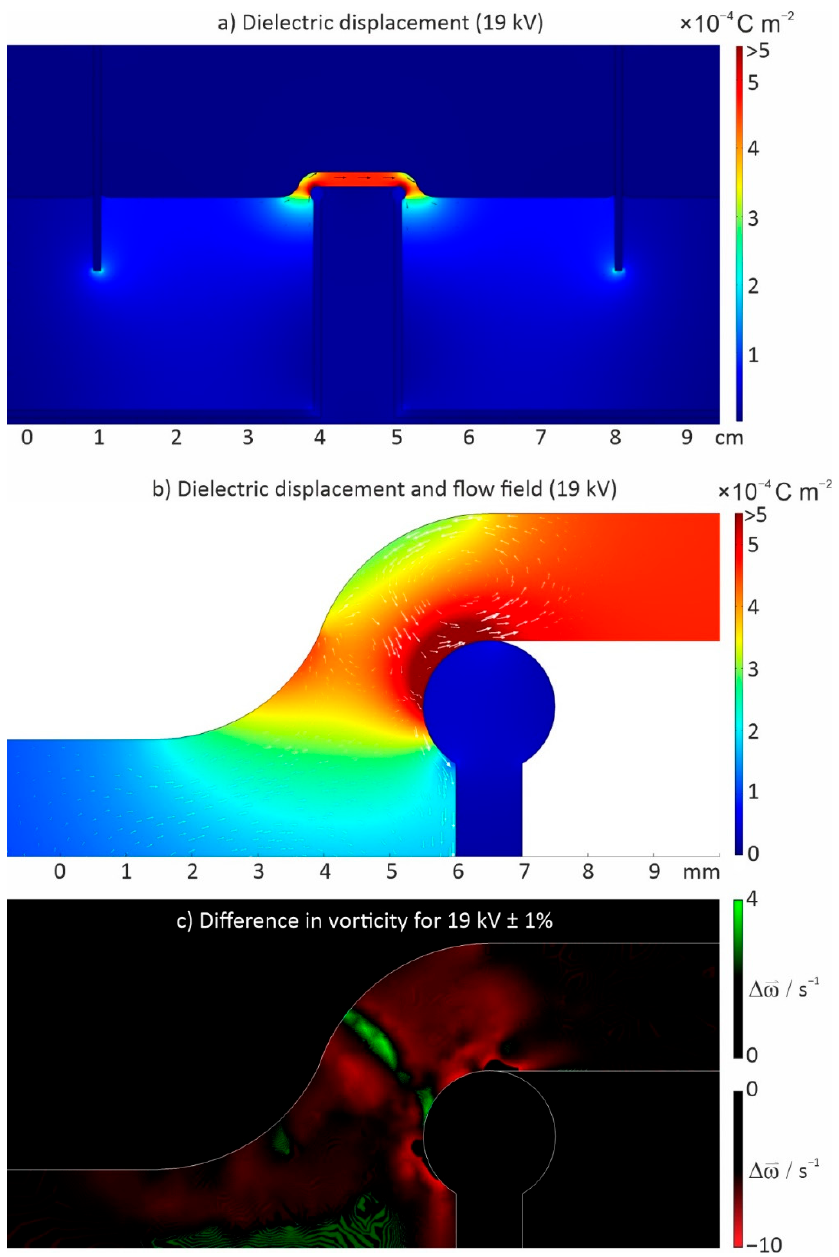
Figure 3. Electrohydrodynamic field simulation of a water bridge operating at 19 kV.: ( a ) Displacement field (black arrows, arrow length proportional to the field scale factor 400, and color map), ( b ) displacement field (color map) and flow field (white arrows, arrow lengths proportional to the velocity, scaling factor 0.5), and ( c ) oscillations in vorticity for a ± 1% deviation in voltage with increased vorticity shown in green, decreased vorticity in red.